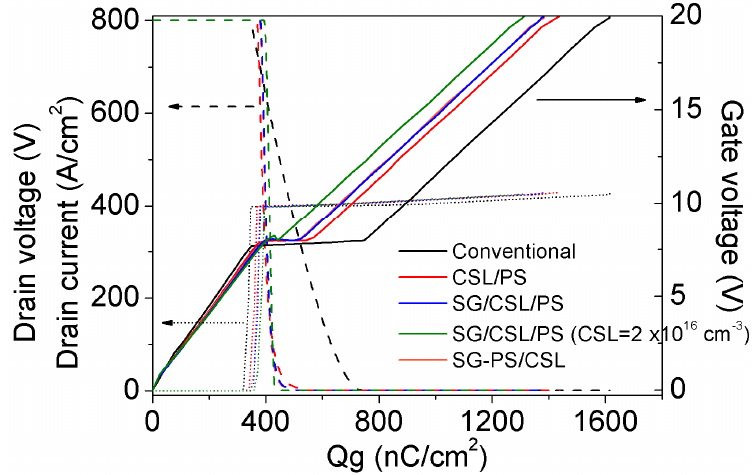
Figure 8. Gate-charge waveforms of conventional, CSL / PS, SG–PS / CSL, and SG / CSL / PS, under 800 V clamped inductive load switching. If not otherwise specified, the CSL doping concentration is 9 × 10 16 cm − 3 . © (2020) IEEE. Reproduced, with permission, from [14].